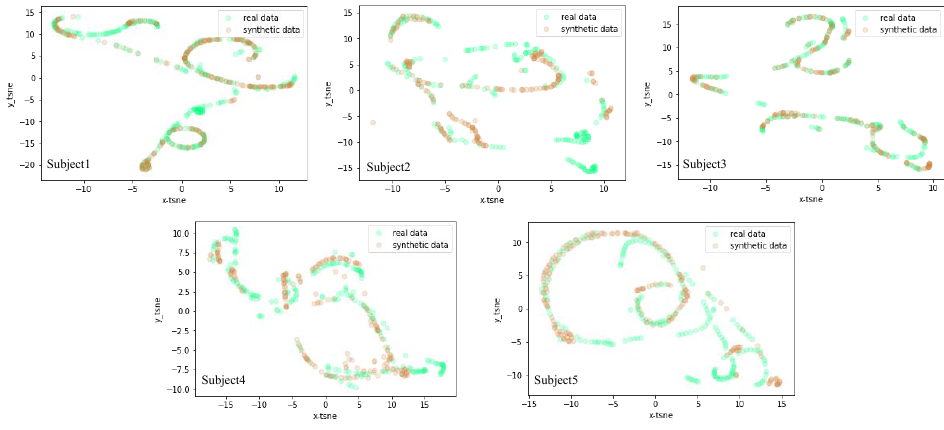
Figure 5. t-SNE visualization on gait data